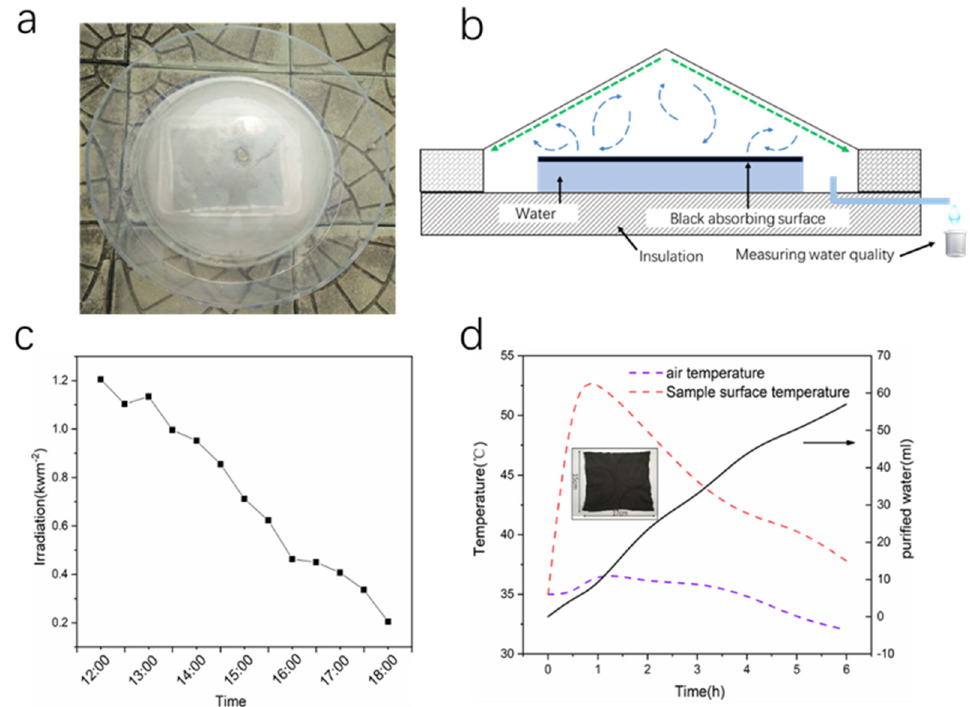
Figure 13. ( a ) A photograph of a large-scale rGO-loaded nonwoven fabric membrane device. ( b ) A schematic diagram of the device collecting water by evaporation. ( c ) Solar radiation recorded over time on a sunny day from 12:00 to 18:00. ( d ) Temperature change with time. The red dotted line represents the surface temperature of the sample, the purple dotted line represents air temperature, the black dotted line represents water evaporation quality changes with time, the illustration shows the size of the